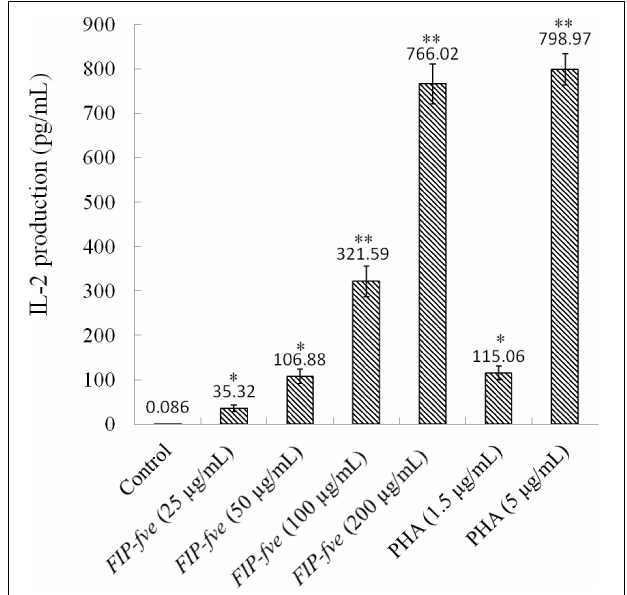
FIGURE 3 | FIP-fve induced IL-2 release in Jurkat E6-1 cells. Jurkat E6-1 cells were treated with or without FIP-fve (25, 50, 100, and 200 µ g/ml) for 6 h.